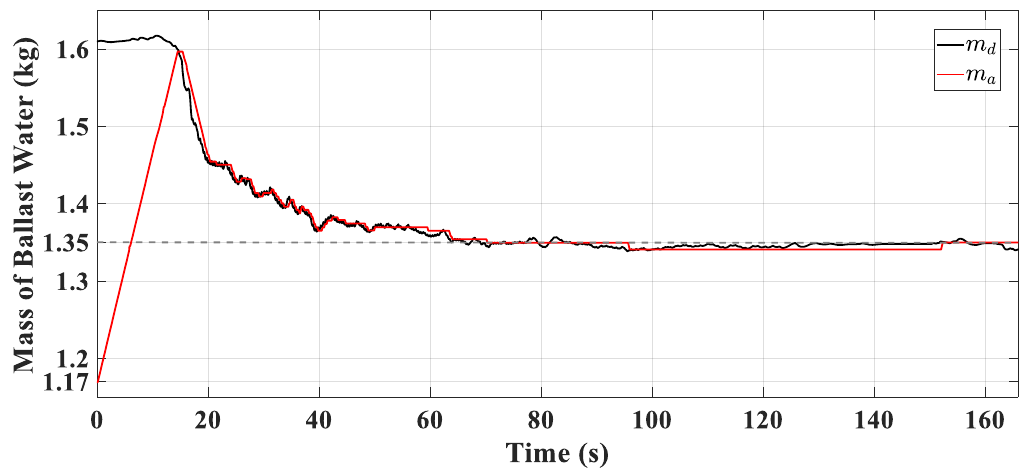
Figure 11. Demanded and actual ballast mass changes of hovering control via on-off type VBS.